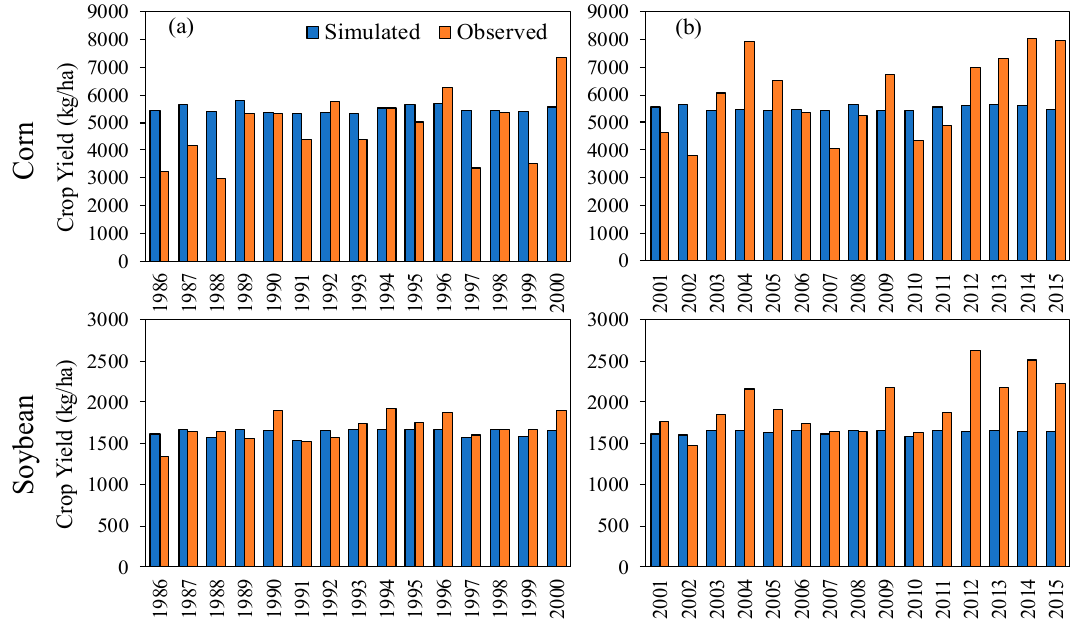
Figure 4. Comparison of National Agricultural Statistics Service (NASS)-observed and SWAT-simulated crop yields for corn and soybean for the ( a ) calibration (1986–2000) and the ( b ) validation period (2001–2015).